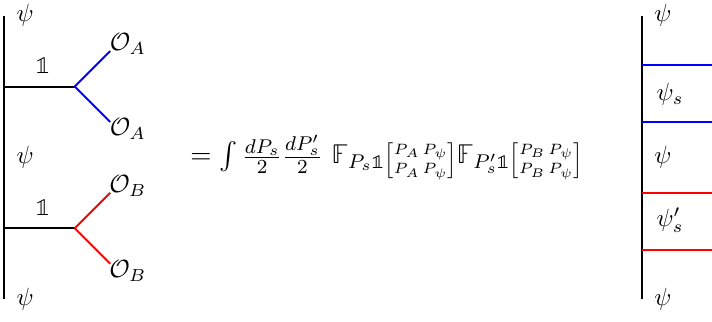
Figure 3 . Diagram of the fusion transformation that was used to compute the four-point left moving vacuum block in the appropriate limit. The blue (red) line corresponds to the external O A ( O B )